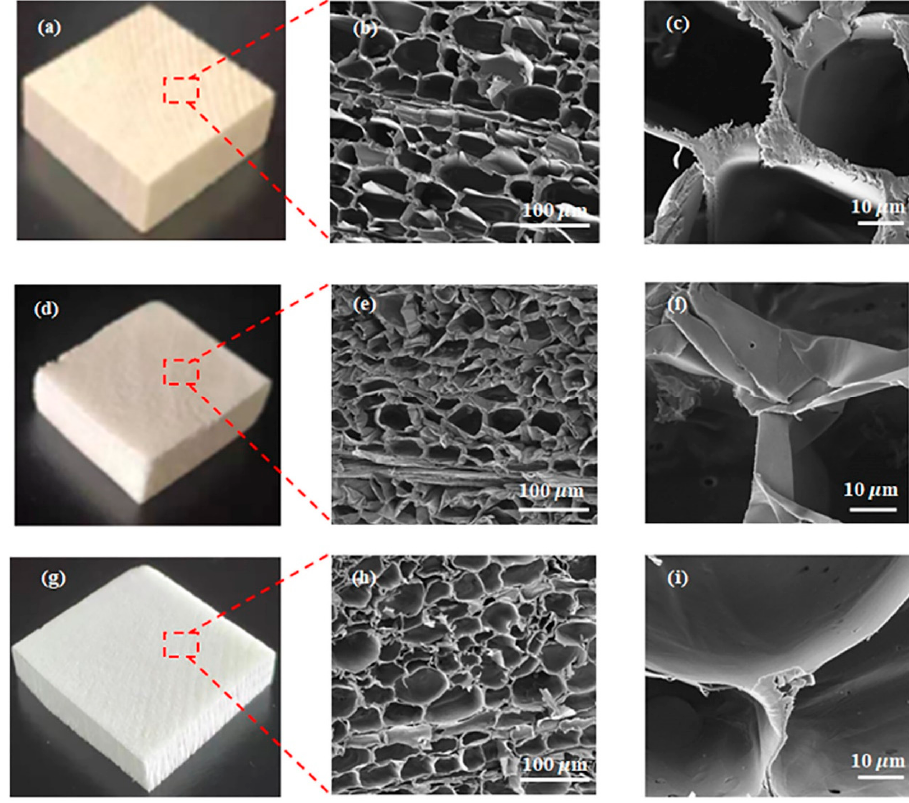
Figure 2. Optical photographs and SEM images of ( a − c ) NW, ( d − f ) DW, and ( g − i ) DW/Si-10 aerogel.